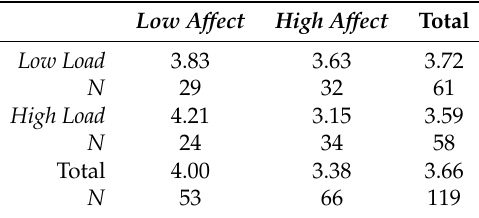
Table A2. Mean donations made by